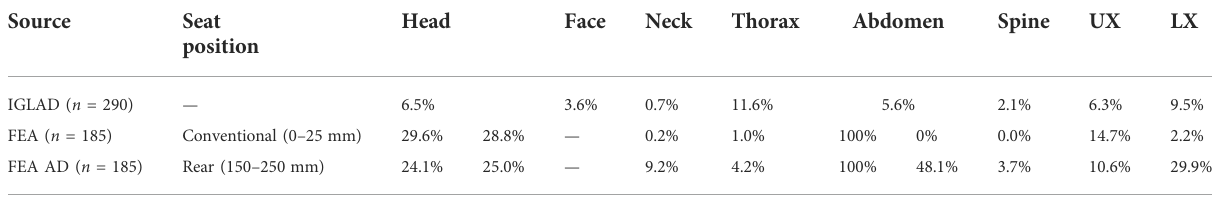
TABLE 3 MAIS2+ body region level injury frequencies from the IGLAD sample and the two sets of FE simulations with conventional and automated driving (AD) seat positions. To ensure consistency, only the 185 simulations which terminated normally in both sets were considered. Source Seat